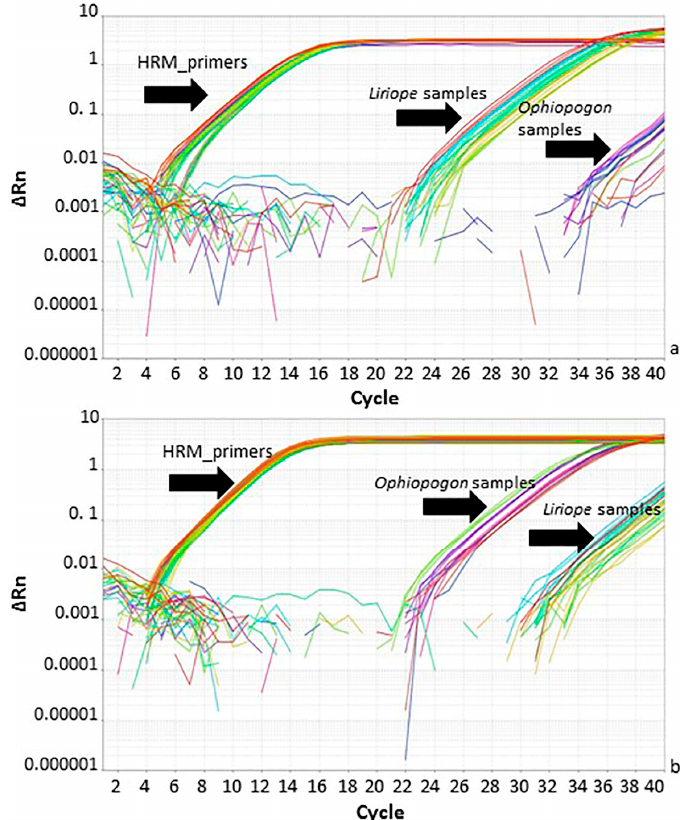
Figure 5. Real-time PCR amplification using Ophiopogon -specific, Liriope -specific and generic high-resolution melt curve (HRM) primers. ( a ) Amplification plot of Liriope -specific and HRM primers. ( b ) Amplification plot with Ophiopogon -specific and HRM primers. The black arrows indicate the primer/template combinations: HRM_primers: Ophiopogon and Liriope templates with the generic primers; Liriope samples: Liriope templates with specific primers; Ophiopogon samples: Ophiopogon templates with specific primers.